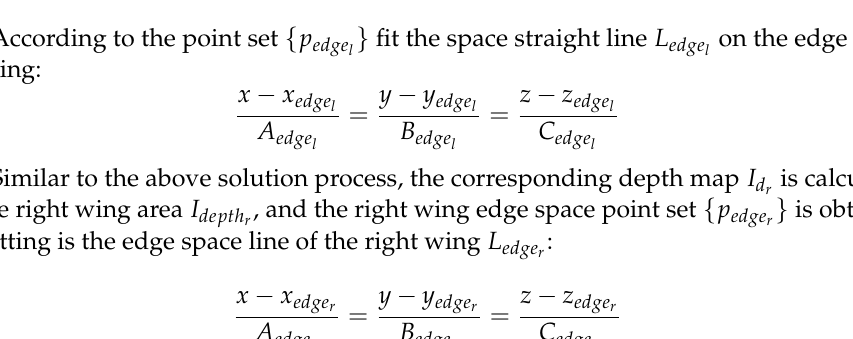
Figure 5. Edge point set projection.